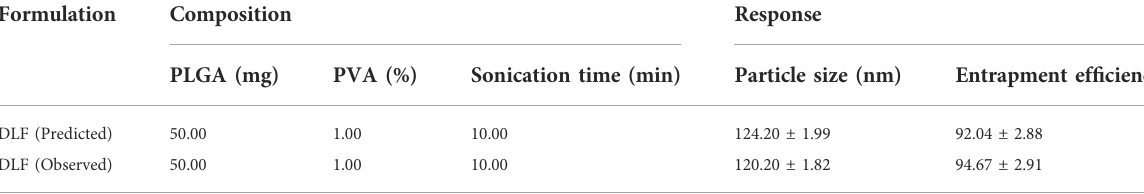
TABLE 3 Predicted and observed values of particle size and % EE of the optimized formulation of DL.